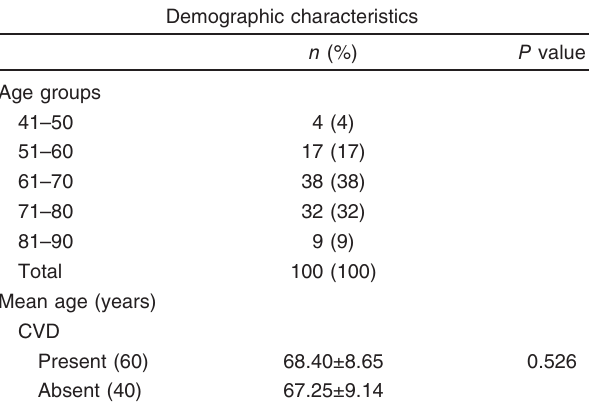
Table 1 Baseline demographic characteristics